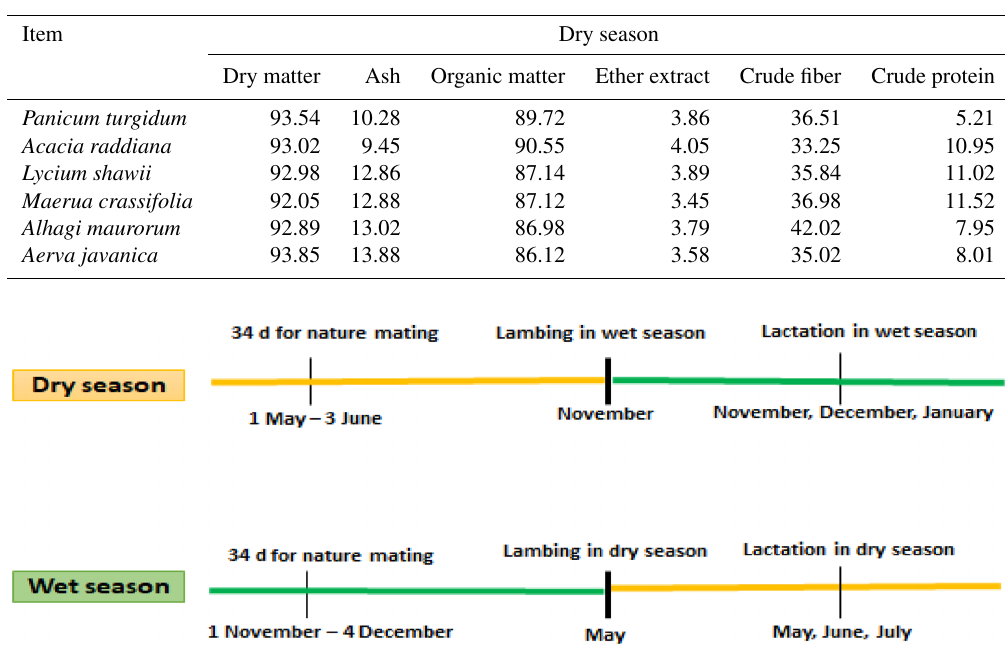
Table 3. Chemical composition of rangeland plants in the Halaieb study area during the dry season (%, dry matter basis).